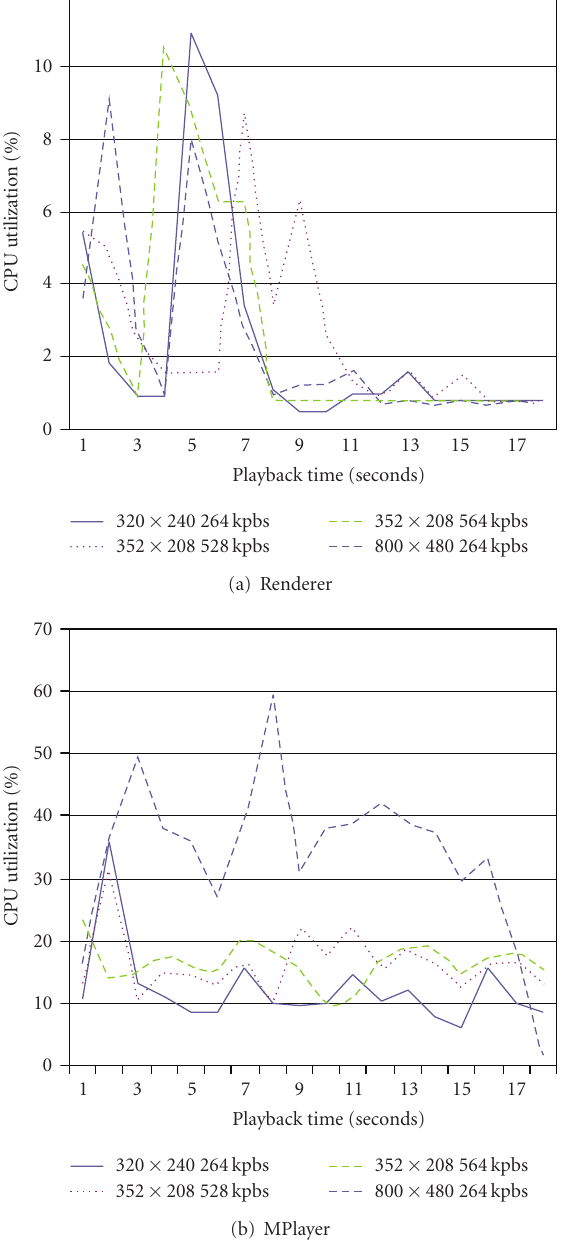
Figure 8: CPU utilization on the Nokia N770.